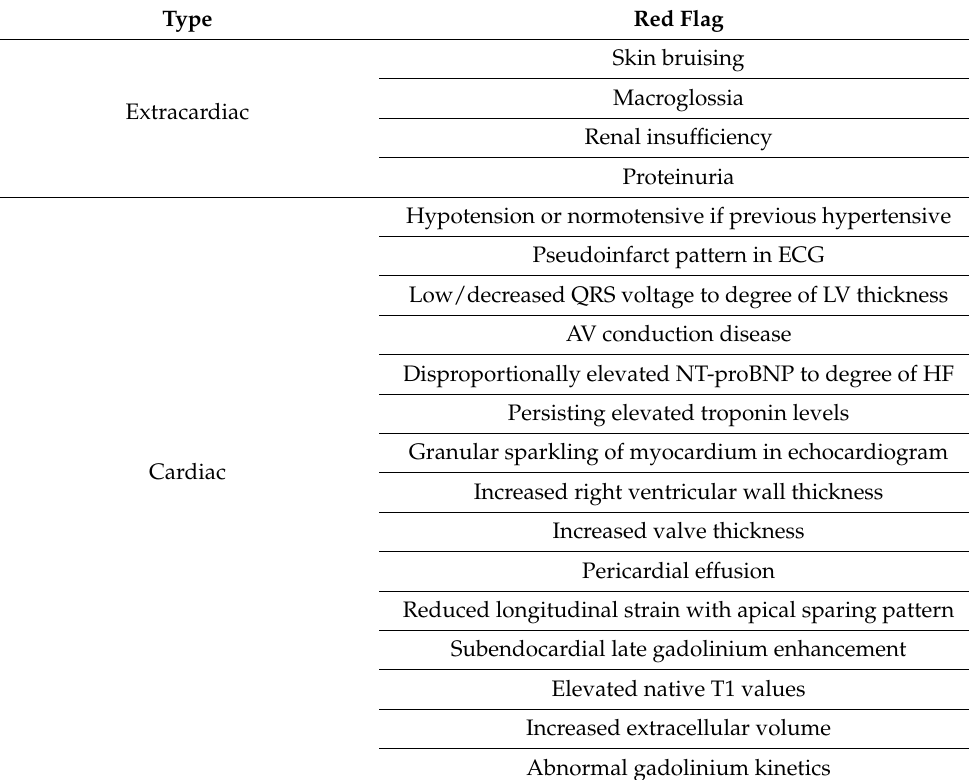
Table 2. Red flags regarding cardiac and extracardiac manifestations of AL amyloidosis (based on [65]). ECG, electrocardiogram; LV, left ventricular; AV, atrio-ventricular; NT-proBNP, N-terminal pro-B-type natriuretic peptide; HF, heart